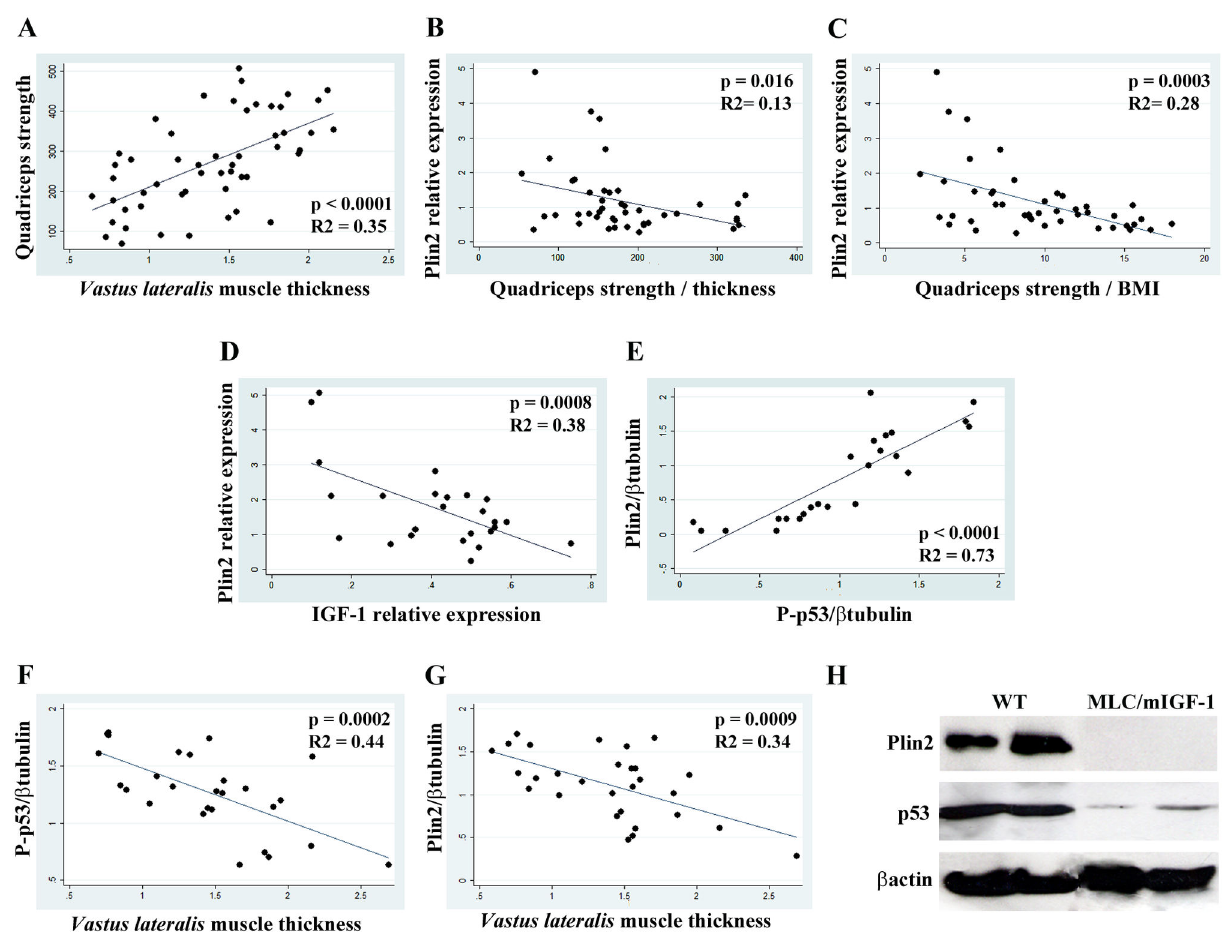
Figure 2. Plin2 association with muscle strength and thickness, and with IGF-1/p53 pathway. ( A ) Linear regression analysis in patients of quadriceps strength (expressed in Newton) and VL thickness. ( B , C ) Linear regression analysis in patients of Plin2 relative expression and quadriceps strength normalised for thickness or BMI, respectively. ( D , E ) Linear regression analysis in healthy subjects and patients of Plin2 and IGF-1 relative expression level (Real time RT-PCR), and of Plin2 and serine-20 phosphorylated p53 protein expression (relative band intensity), respectively. ( F , G ) Linear regression analysis in healthy subjects and patients of serine-20 phosphorylated p53 protein expression and VL thickness, and Plin2 and VL thickness, respectively. ( H ) Representative WB analysis for Plin2 and total p53 in wild type (WT) and transgenic IGF-1 (MLC/mIGF-1) old mice (23-25 months). βactin is used as protein loading